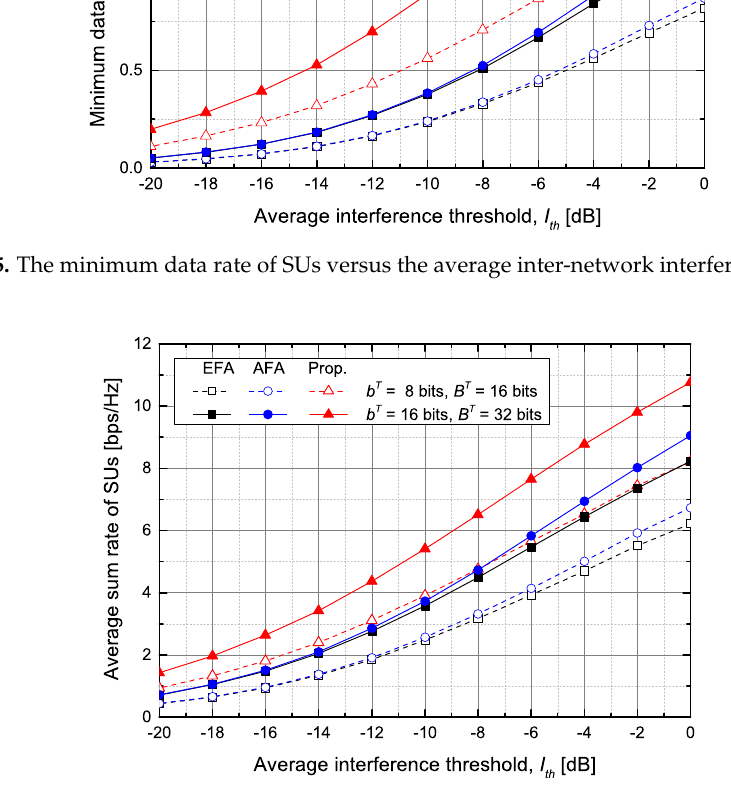
Figure 6. The average sum rate of SUs versus the average inter-network interference